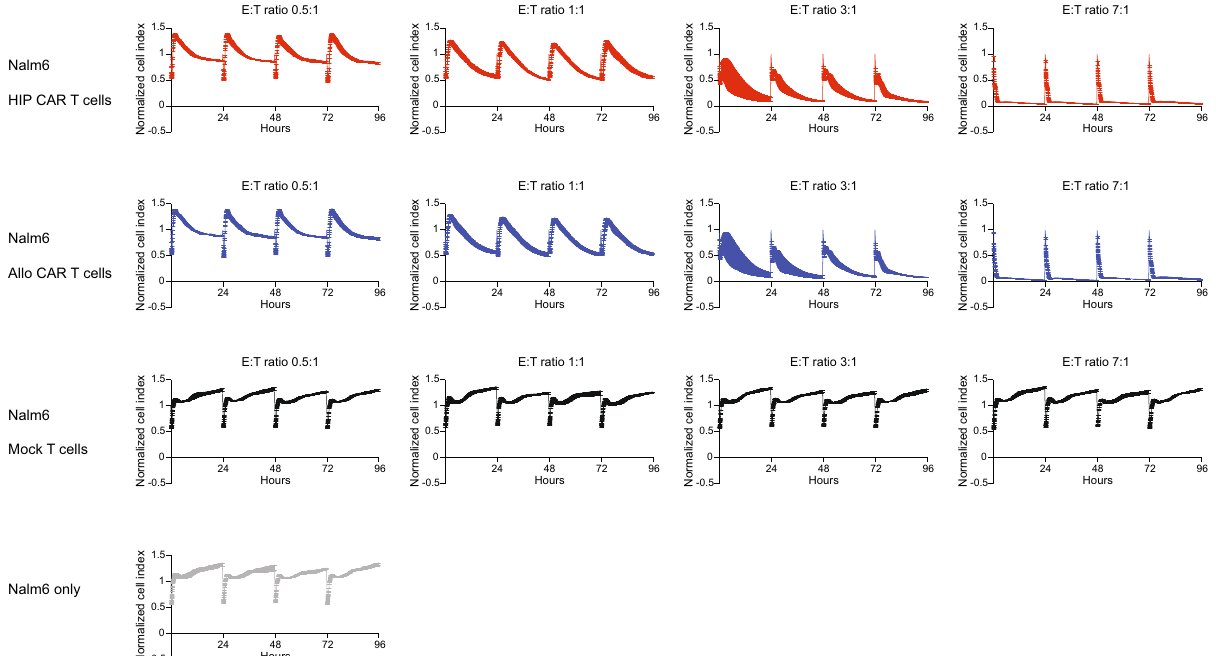
Fig.3|CARTcellsarerepeatedlyre-challengedwithNalm6tumorcellsinvitro. Different doses of HIP CAR T cells, allo CAR T cells, or Mock T cells were used as effectors against Nalm6 target cells in impedance cytotoxicity assays (mean±SD, three independent replicates per group and time point in one experiment). The